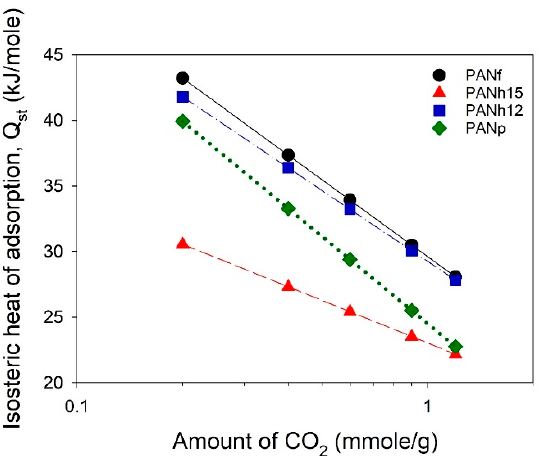
correlation analysis. Moreover, the CO 2 uptake at 1 atm was highly related to pyridine-N oxides and the ratio of V mi to V t .